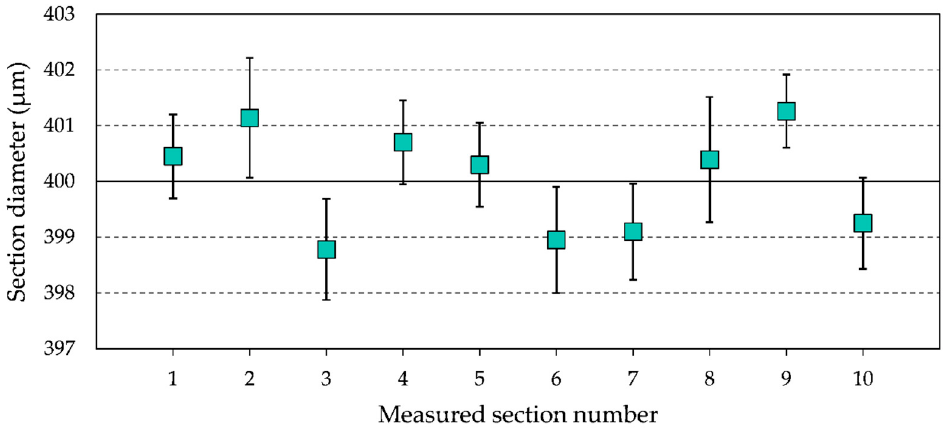
Figure 5. Measurement of the diameter of the WEDG’ed sections of the microrods. Ten different sections are measured, and eight measurements are carried out per section. The data points refer to the mean diameter of each measured section, while the error bars indicate the standard deviation of the eight measurements.